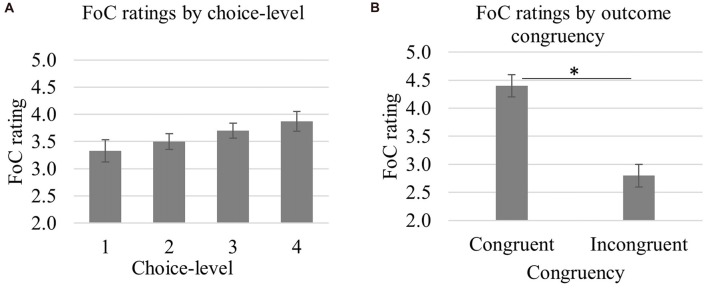
Mean FoC ratings as a function of choice-level (A) and outcome congruency (B). FoC ratings were significantly increased with increasing choice-level (p = 0.027) and were higher for congruent compared to incongruent outcomes (*p < 0.001). Error bars represent standard error of the mean.